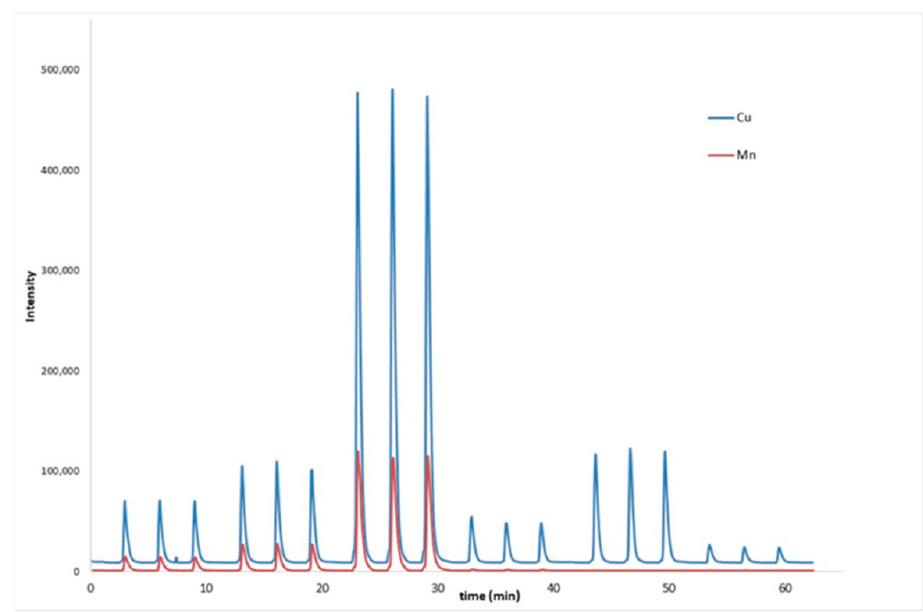
Figure 2. Recording of the signal corresponding to standards (0.05, 0.1, and 0.5 mg L − 1 ) and samples with synchronization. Cu (blue), Mn